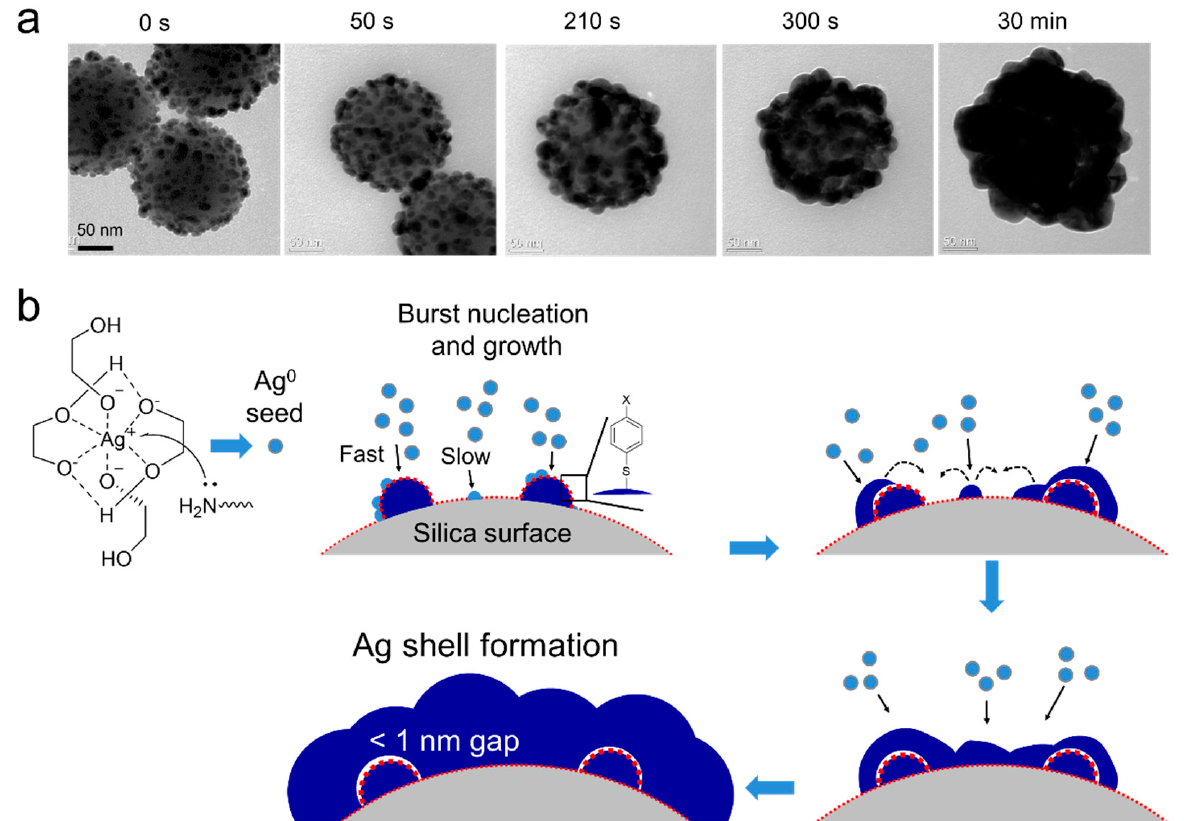
Figure 2. Observation and proposed mechanism of the shelling progress for Ag NGS structures. ( a ) TEM images of early-stage Ag NGS formation. Ag NPs coated on silica surfaces grew slowly at first, and additional seeding started after approximately 300 s. ( b ) Proposed mechanism of the Ag shelling progress starting from Ag silica. Ag + ions in EG were easily reduced by octylamine using a chelating effect, and Ag 0 rapidly induced the growth of Ag NPs on the silica surface. Ag 0 approached the silica surface directly and slowly grew to form Ag NPs. Finally, the surface was fully covered with a robust Ag shell. Black line and dashed arrows indicate the nucleation and growth, respectively.